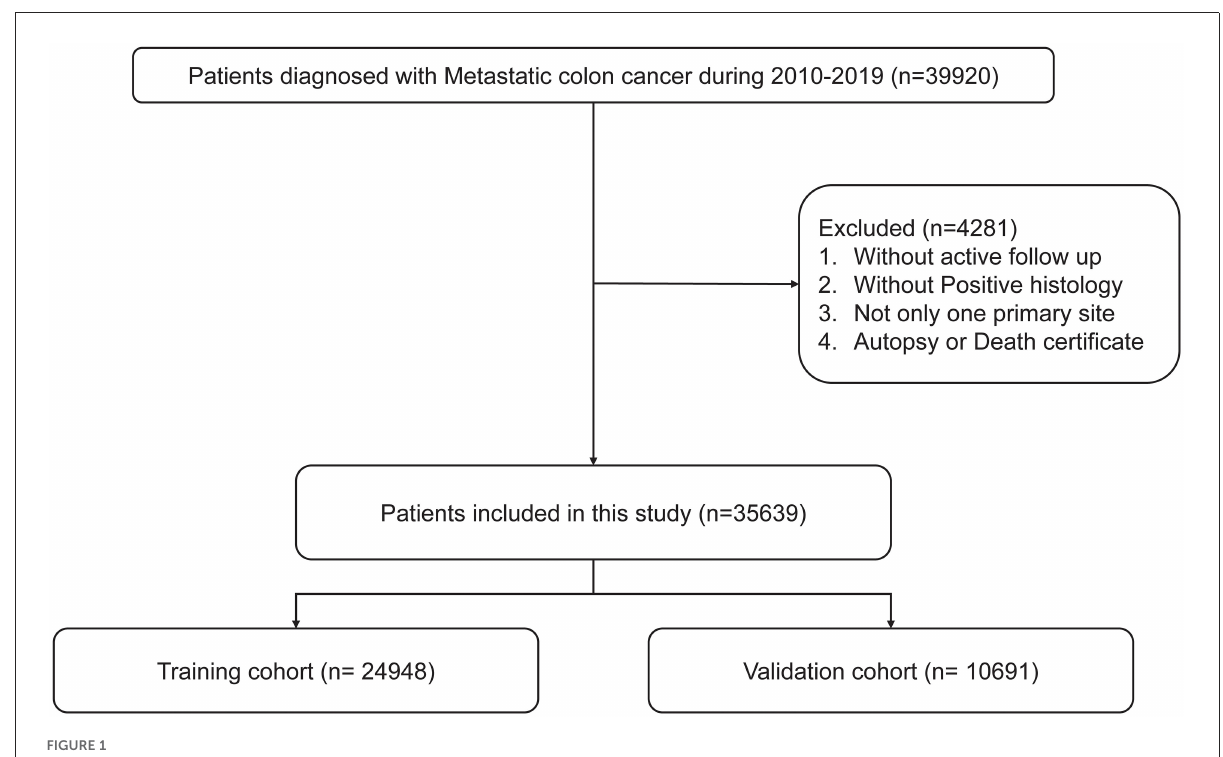
FIGURE1 Flowchart for selection procedure of patients with